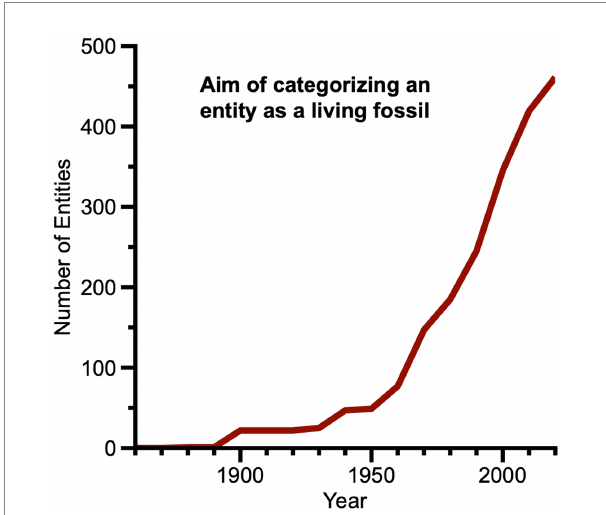
FIGURE 11 Line graph showing changes from 1860 to 2020 in numbers of entities in publications where at least one of whose aims appeared to be categorizing an entity as a living fossil (or